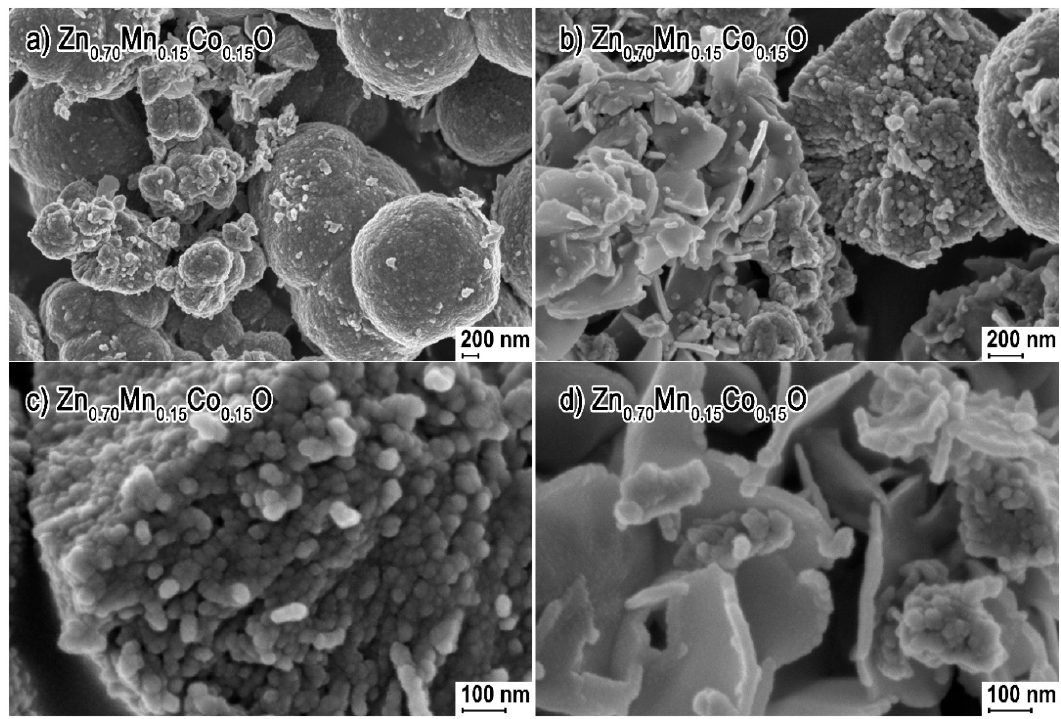
Figure 3. SEM images of NPs: ( a – d ) Zn 0.7 Co 0.15 Mn 0.15 O.